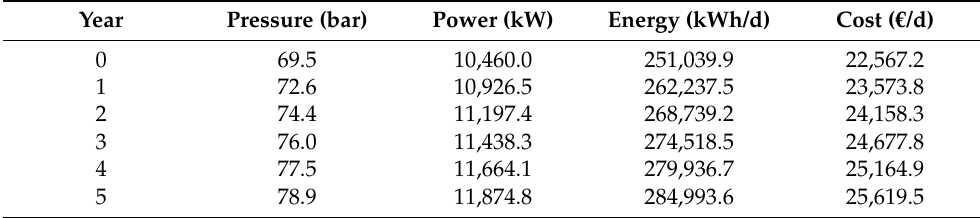
Table 4. Pressure increases without membrane replacement at 17 ◦ C.